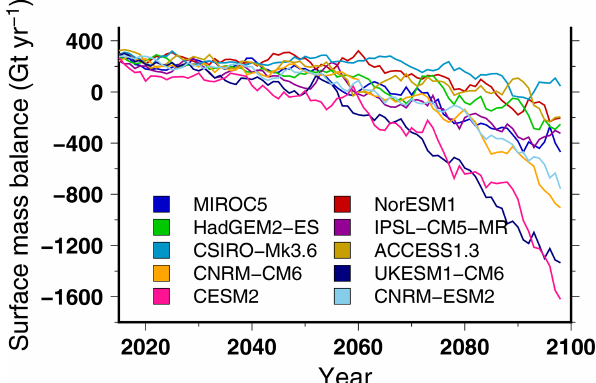
Figure 5. Simulated surface mass balance, integrated over the ice sheet, for different CMIP5 and CMIP6 climate forcings using the RCP8.5 scenario and SSP585 scenario, respectively. The projection experiments shown in this figure use the medium oceanic sensitiv- ity. For this figure we use a 5-year running mean in order to smooth the interannual